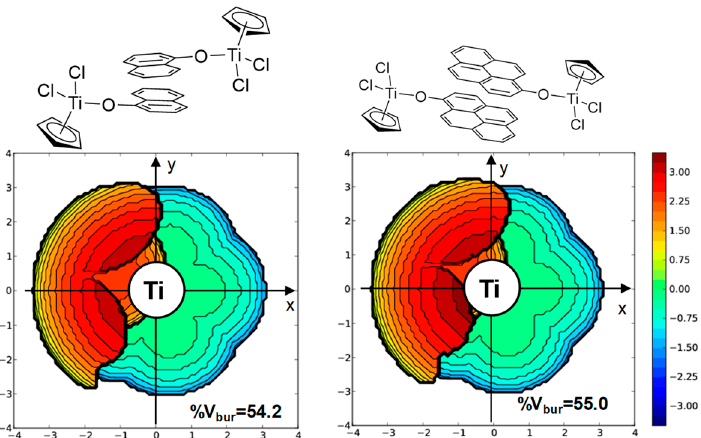
Figure 5. Steric crowding maps from buried volume calculations for π - π stacked Ti1 ( left ) and Ti3 ( right ).